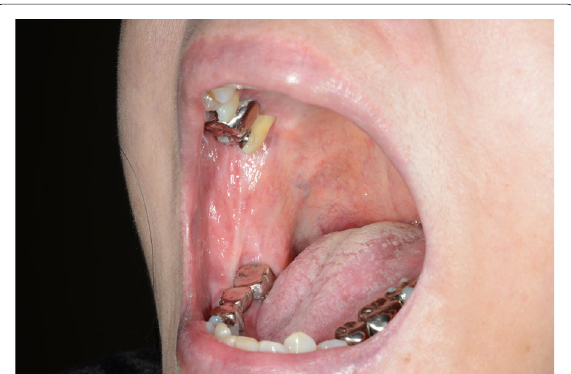
Fig. 10 Intraoral examination at 9 months